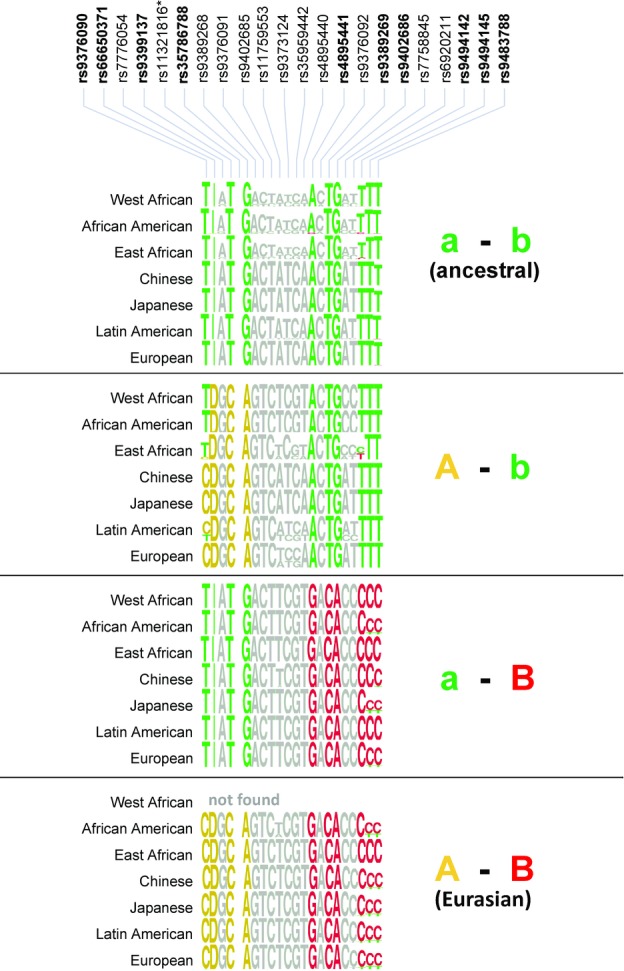
Consensus composition of the four HMIP-2 haplotype clades in major population groups. The consensus composition (sequence logos [Schneider & Stephens, 1990]) for the HMIP-2 haplotype clades was assembled from phased genotyped data provided by the 1000 Genomes Project (Abecasis et al., 2010). The fourteen reference populations were pooled into seven groups to increase sample numbers. HbF-associated variants (colored) and clade definition are the same as in Figure4.These data show that the identity and composition of HMIP-2 haplotype clades across global populations is consistent and matches those present in healthy Europeans and African-descended SCA patients (Fig.4): only two types of HbF-increasing haplotype signatures are present, those of the “A” and of the “B” type. Clades are either ancestral (“a–b,” typical for a low HbF situation), or “A–b,” “a–B”, and “A–B” (all predicted to carry high-HbF alleles). Allele frequency data underlying these plots are detailed in Table S4.*rs113211816 data were not available.